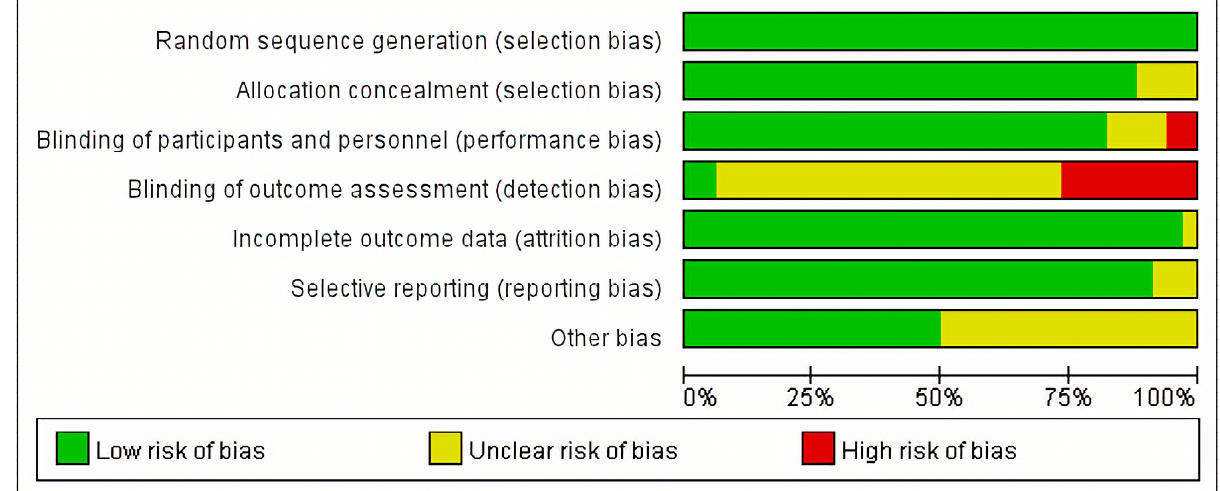
Figure 2. Risk of bias graph: review authors’ judgements about each risk of bias item presented as percentages across all included studies. Table 1. Baseline characteristics of included studies for meta-analysis.